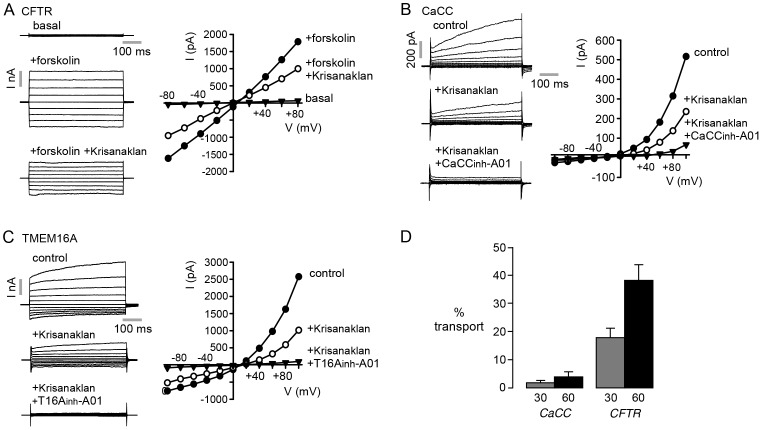
Whole-cell patch-clamp analysis of Krisanaklan Cl− channel inhibition.A. CFTR currents measured at a holding potential of 0−80 mV and +80 mV (in steps of 20 mV) in FRT cells expressing CFTR. Currents were recorded without forskolin (basal), and with 10 µM forskolin without or with Krisanaklan (1∶2000 dilution). (right) Current/voltage (I/V) plot of mean currents at 400 ms. B. (left) CaCC currents recorded in control conditions, in the presence of Krisanaklan, and in the presence of Krisanaklan (1∶2000 dilution) and 100 µM CaCCinh-A01. Currents were recorded at voltages of −100 to +100 mV in 20 mV steps from a holding potential of −50 mV. (right) I/V plot of mean currents at 500 ms. C. (left) Whole-cell TMEM16A Cl− currents recorded at a holding potential of 0 mV and pulsing to voltages between −100 and +100 mV (in steps of 20 mV) in TMEM16A-expressing FRT cells. Measurements done in the absence and presence of Krisanaklan (1∶2000 dilution), and TMEM16A inhibitor T16Ainh-A01 (10 µM). (right) I/V plot of mean currents at 500 ms. D. Transepithelial transport of active components in Krisanaklan in T84 cells grown on a porous transwell insert. Percentage transport of Krisanaklan inhibitory compound(s) at 30 and 60 min measured by bioassay of Cl− channel inhibition (mean ± S.E., n = 3).